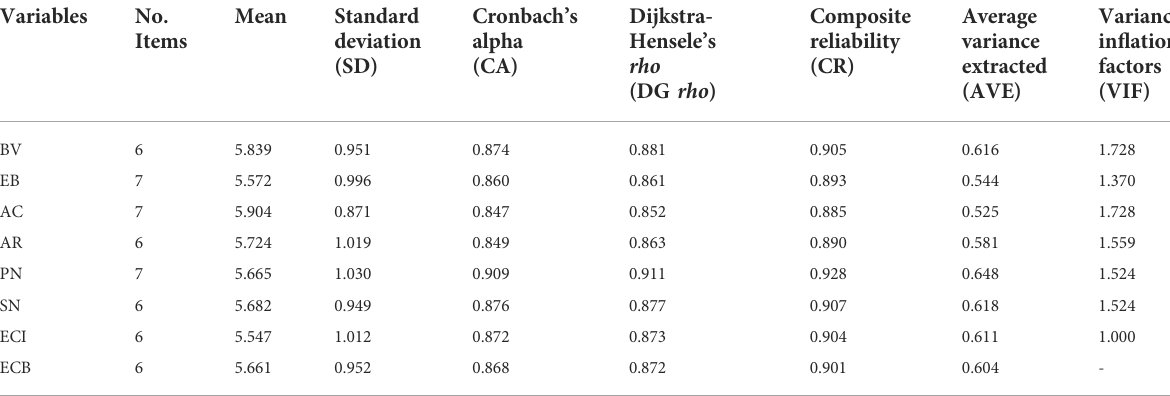
TABLE 3 Reliability and